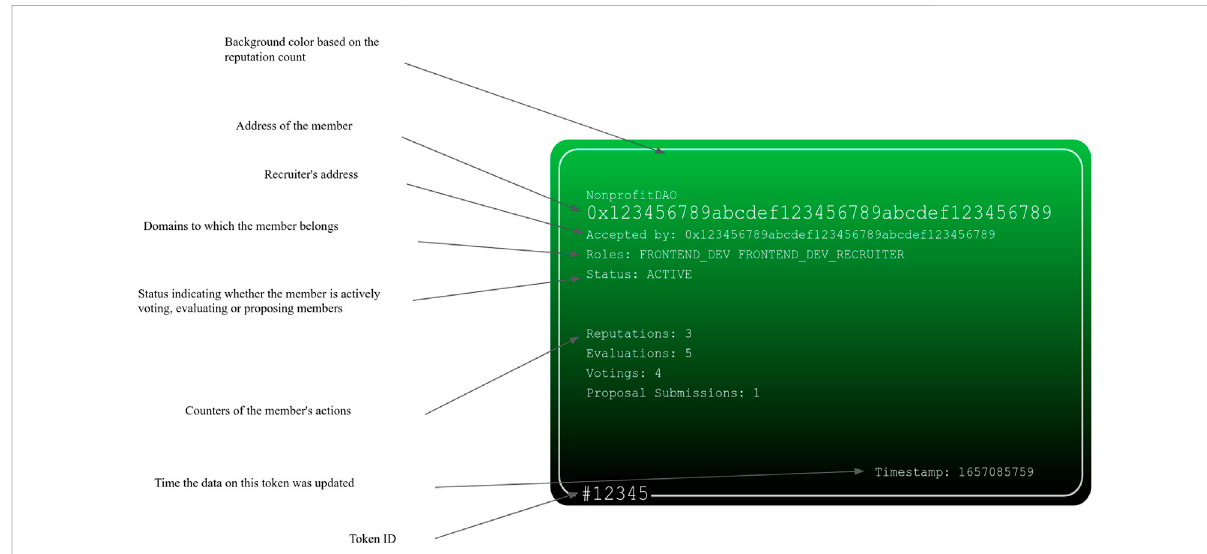
FIGURE 2 An illustrative example instance of the SBRT implemented in this